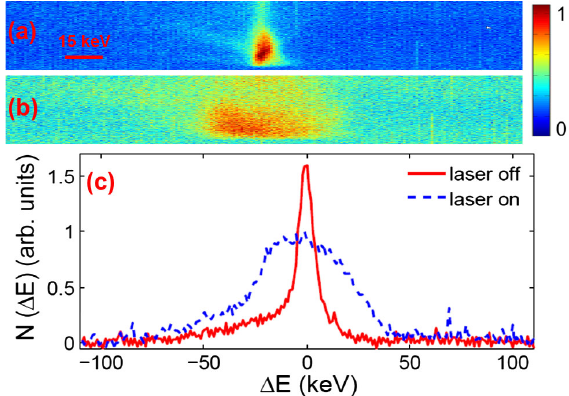
FIG. 7. Measured beam energy distributions with laser off (a) and laser on (b) at about 54 MeV (corresponding to the 15th harmonic interaction). The beam intensity in (a) is reduced by a factor of 2 to avoid saturation using the same scaling as (b). The projections of beam energy distributions in (a) and (b) are shown in